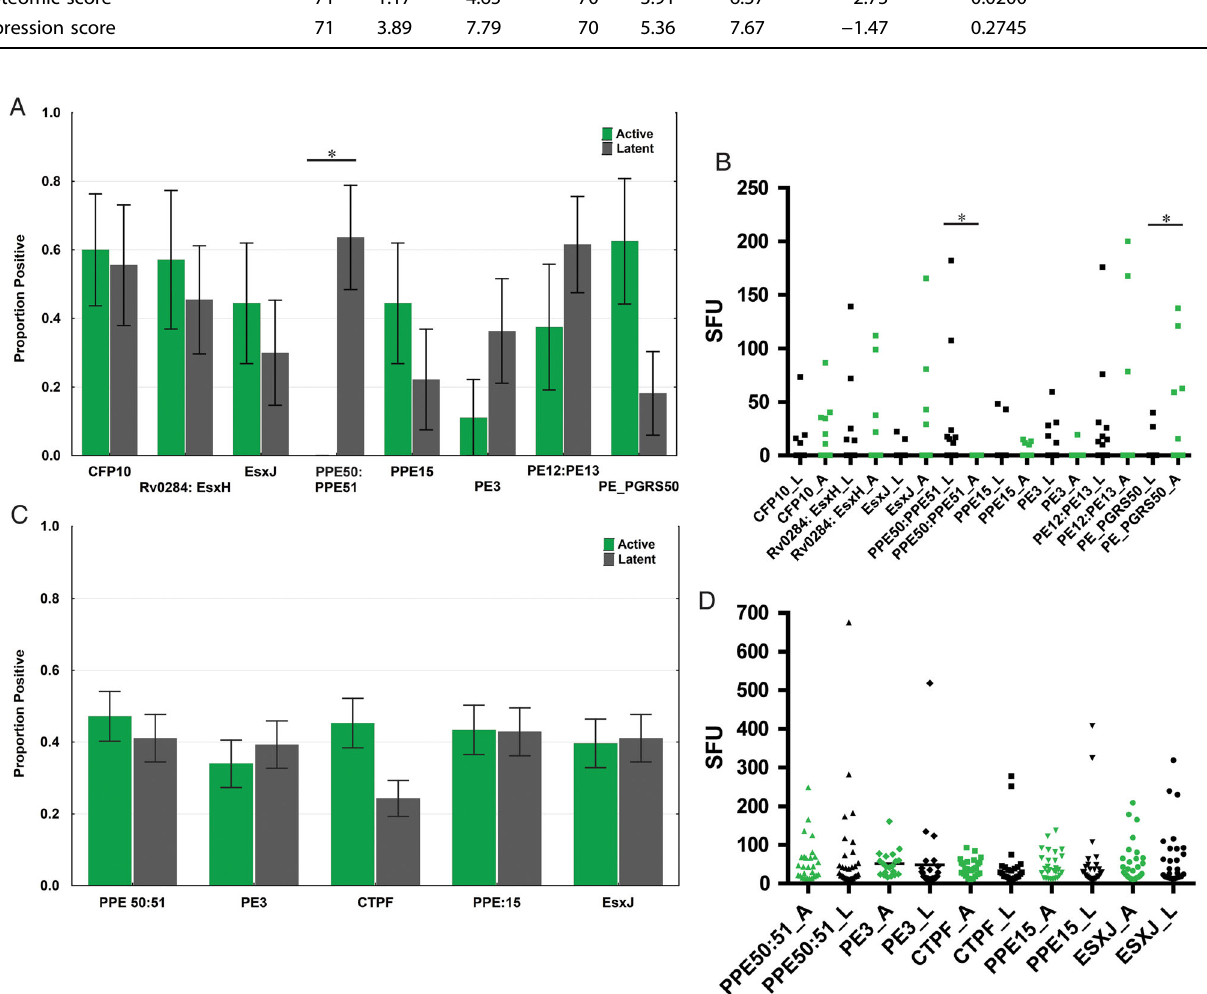
Fig. 4 Clinical Validation of Immunodominant Peptide Pools in Mtb-infected Individuals in Kampala, Uganda. a , b IFN- γ ELISPOT was performed on CD4/CD56 depleted PBMC from approximately 10 subjects with LTBI and 10 with TB. a Results are shown as percent positive assays. Black bars indicate participants with LTBI and green bars indicate participants with active TB. For the PPE51:PPE50 peptide pool, the asterisk denotes that the difference in proportion positive between those with LTBI and active TB was statistically signi fi cant ( p = 0.004, Fisher ’ s exact test). b The associated magnitude of responses reported in SFU is shown. Black dots indicate participants with LTBI and green dots indicate participants with active TB. For the PPE51:PPE50 and PE_PGRS50 peptides pools, the asterisks denote that the difference in SFU between those with LTBI and active TB were statistically signi fi cant ( p = 0.004 and p = 0.024, respectively, Mann Whitney). c , d Additional validation was performed for fi ve selected antigens. IFN- γ ELISPOT was performed on CD4 depleted PBMC on 50 subjects with LTBI and 50 with TB. c Results are shown strati fi ed by disease phenotype as a percent positive by ELISPOT assays. Black bars indicate participants with LTBI and green bars indicate participants with TB. d The associated magnitude of responses reported in SFU is shown. Black dots indicate participants with LTBI and green dots indicate participants with active